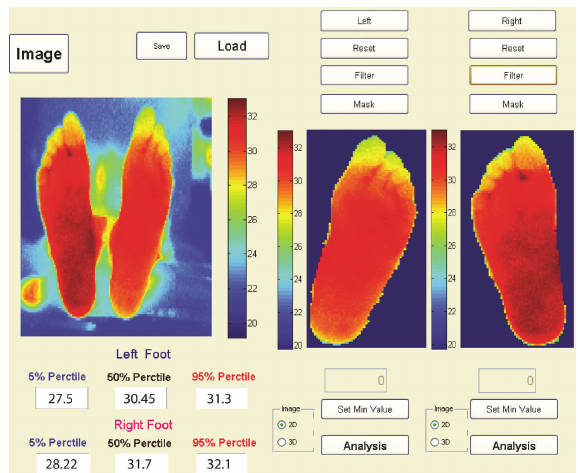
Figure 1: A purpose-designed image processing toolbox was developed using Matlab (version 7.4, The MathWorks, Inc., Natick, MA, USA), to isolate each foot from the thermal image and extract plantar temperature in three anatomical regions of foot including hind-, mid-, and